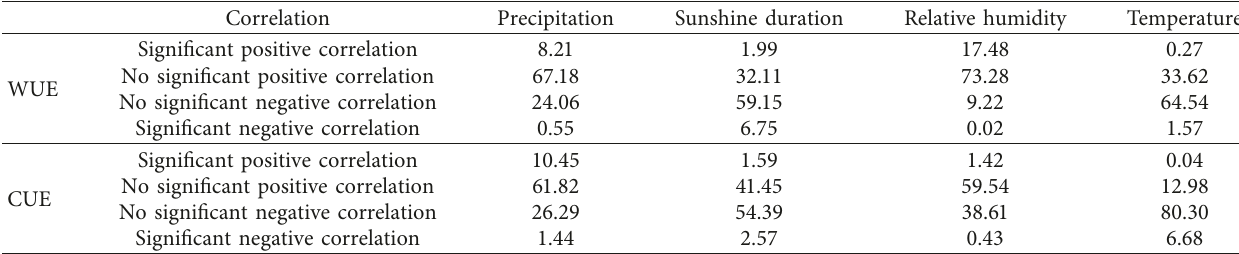
Table 1: Area percentages of the correlation coefficients between WUE, CUE, and climate factors (significant positive correlation ( r > 0, p < 0 . 05): no significant positive correlation ( r > 0, p < 0 . 05), no significant negative correlation ( r < 0, p > 0 . 05), and significant negative correlation ( r < 0, p < 0 .